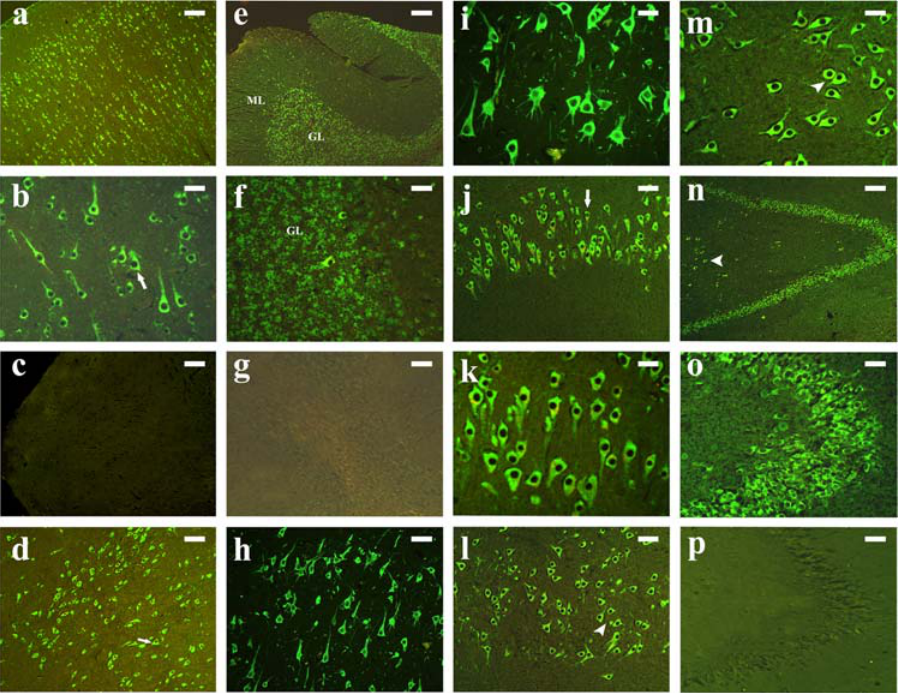
Figure 2. Localization of CYP3A43 mRNA in human brain by fluorescence in situ hybridization. (a) Intense fluorescence was seen in neuronal cell layers of frontal cortex. Differential localization was seen delineating the laminar architecture of the cortex. Bar=100 m m (b) Higher magnification of cortical neurons (arrow). Bar=25 m m (c) Control section hybridized with sense probe did not show any fluorescence. Bar=100 m m (d) Reticular neurons in the midbrain expressed CYP3A43 mRNA. Bar=100 m m (e) Fluorescent labelling of the granule cell layer (GL) in human cerebellum. Sparse staining was observed in the molecular layer (ML). Bar=100 m m (f) Higher magnification of neurons of the granule cell layer in cerebellum. Bar=25 m m (g) Control section hybridised with sense probe. Bar=100 m m (h) CYP3A43 expression was seen in pyramidal neurons of CA1 in the hippocampus. Bar=50 m m (i) Higher magnification of CA1 neurons. Bar=25 m m (j) Robust staining of the CA2 pyramidal cell layer (arrow) of the hippocampus. Bar=50 m m (k) Higher magnification of pyramidal neurons in the CA2 subfield. Bar=25 m m (l) Intense fluorescence was seen in the CA3 pyramidal neurons (arrow head) of the human brain. Bar=50 m m (m) Higher magnification of CA3 neurons (arrow head). Bar=25 m m (n) Intense fluorescence was observed in the dentate gyrus. Staining of the interneurons of the hilus (arrow head) was also observed. Bar=100 m m (o) Higher magnification of the granule cells in the dentate gyrus. Bar=25 m m (p) Control section of hippocampus hybridized with sense probe did not show any fluorescence. Bar=100 m